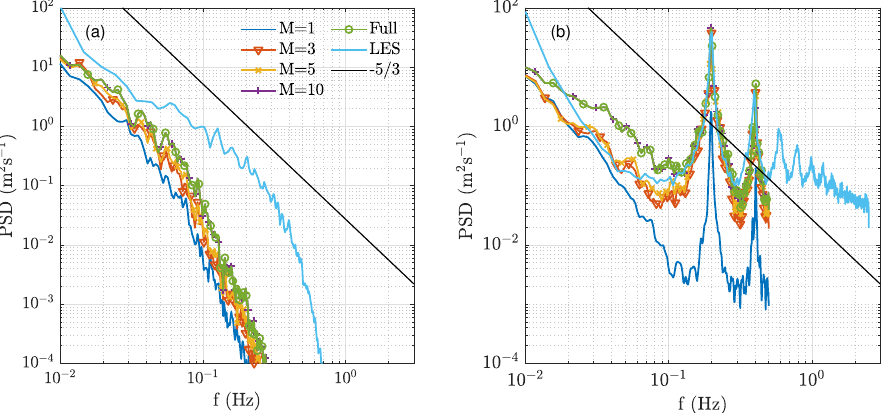
Figure 10. ( a ) Fixed point spectra of the v los velocity on the rotor axis at an upstream measurement distance of 126 m with M = 1, 3, 5 and 10 modes. ( b ) Rotational spectra of the u projected velocities of the reduced-order reconstruction with M = 1, 3, 5 and 10 modes. The results are shown only for the CBL